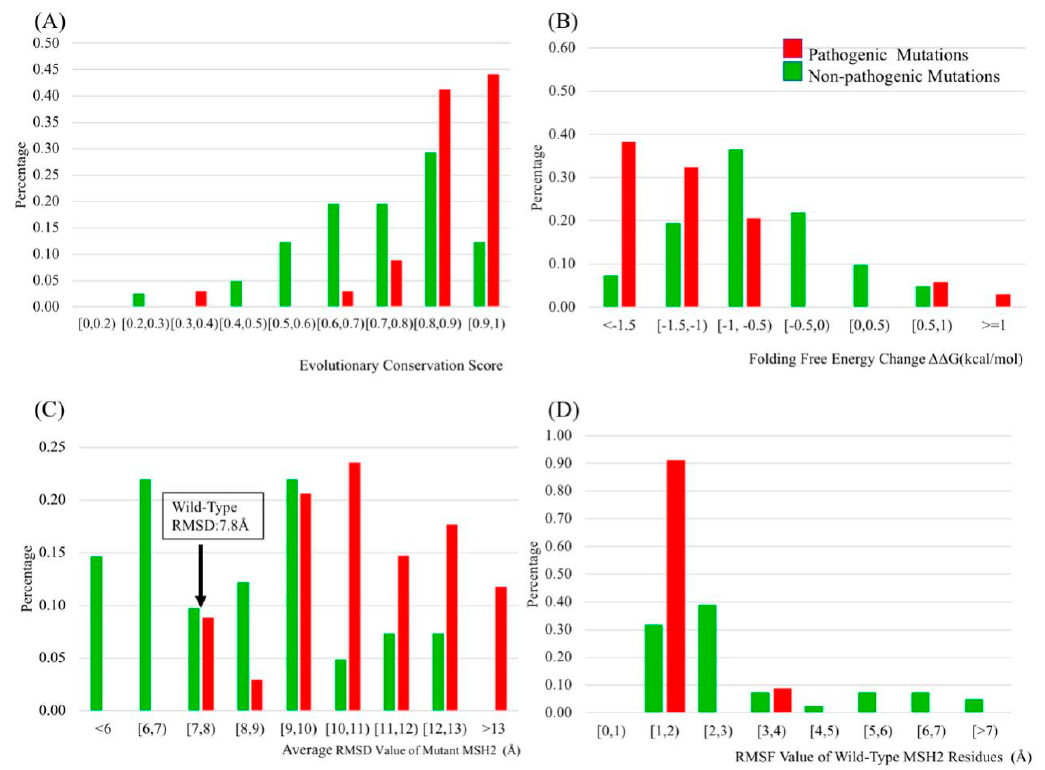
Figure 3. The distribution of evolutionary conservation score, folding free energy change upon the mutations, the average RMSD value of the MSH2 C α , and the RMSF value of the MSH2 wild-type residues. ( A ) There were around 2 / 3 of the non-pathogenic mutations with an EC score below 80%; in contrast, more than 80% of pathogenic mutations have an evolutionary conservation score (ECS) higher than 80%. ( B ) This figure demonstrates that around 30% of non-pathogenic mutations had a ∆∆ G between − 0.5 kcal / mol and 0.5 kcal / mol. However, most of the pathogenic mutations had a larger ∆∆ G comparing to non-pathogenic mutations. ( C ) The average RMSD value of wild-type MSH2 protein was 7.8 Å. Some non-pathogenic mutants had a RMSD value lower than the wild-type, but pathogenic MSH2 mutants usually have a much higher value than the wild-type. ( D ) The RMSF value of wild-type residues were calculated. Residues with a corresponding pathogenic mutation were labeled as red, and residues with a corresponding non-pathogenic mutation were labeled as green. More than 90% of wild-type residues on pathogenic positions had a RMSF between 1 to 2 Å, but most of wild-type residues on non-pathogenic positions have a larger RMSF value.